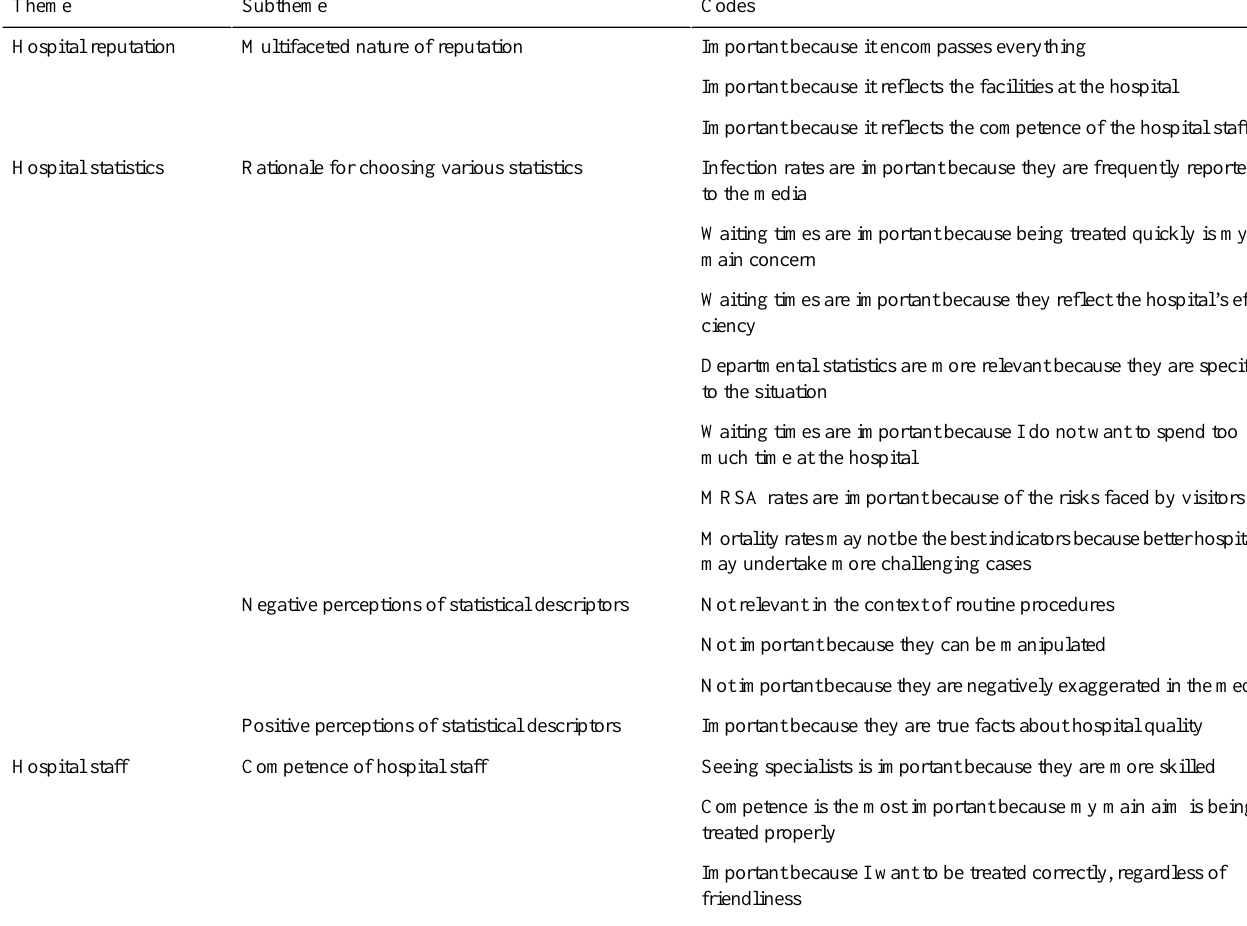
Table 4. Themes, subthemes, and codes from focus groups.